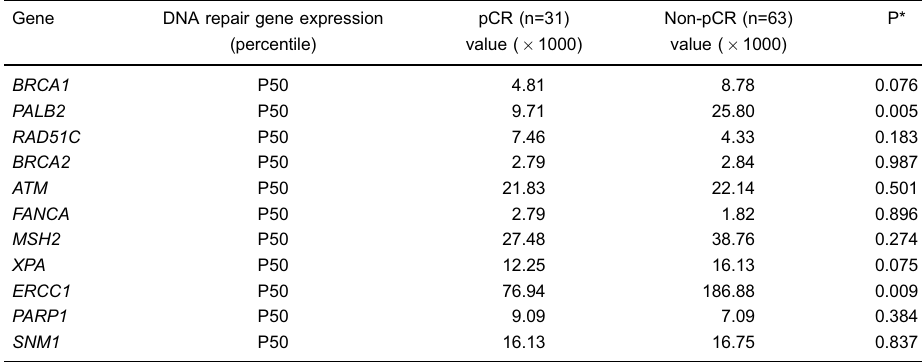
Table 1. DNA repair gene expression in pre-NACT biopsies by pathologic complete response (pCR).